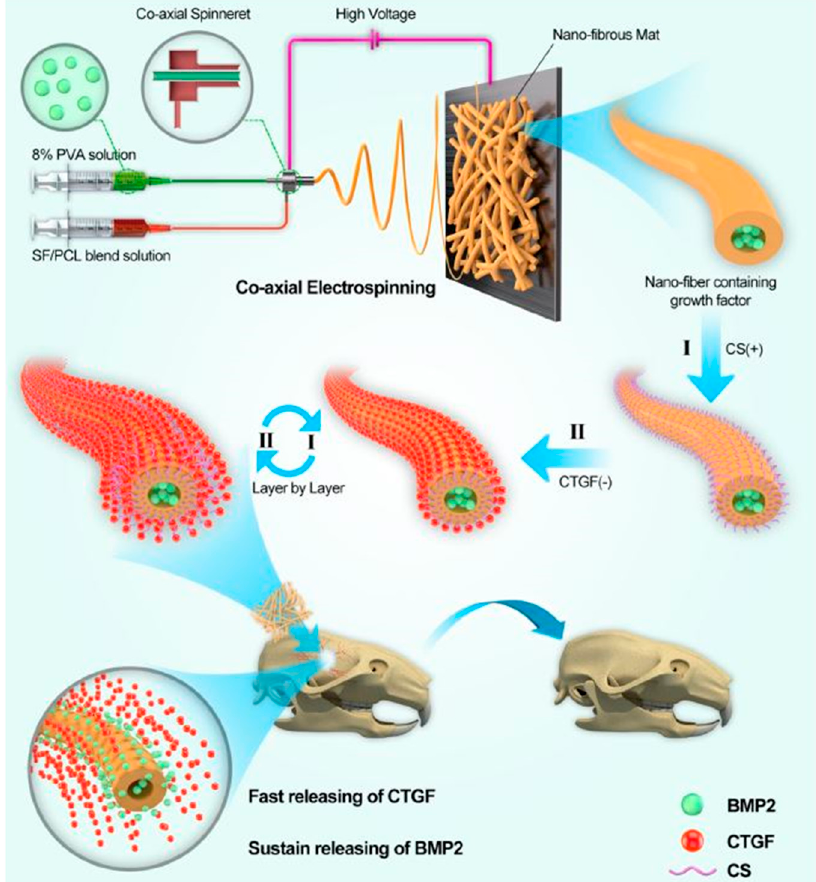
Figure 5. Layer-by-layer assembly of core-shell NFs for controlled co-delivery of growth factors for bone tissue engineering. Reproduced with permission from [66], Copyright © 2021, American Chemical Society.